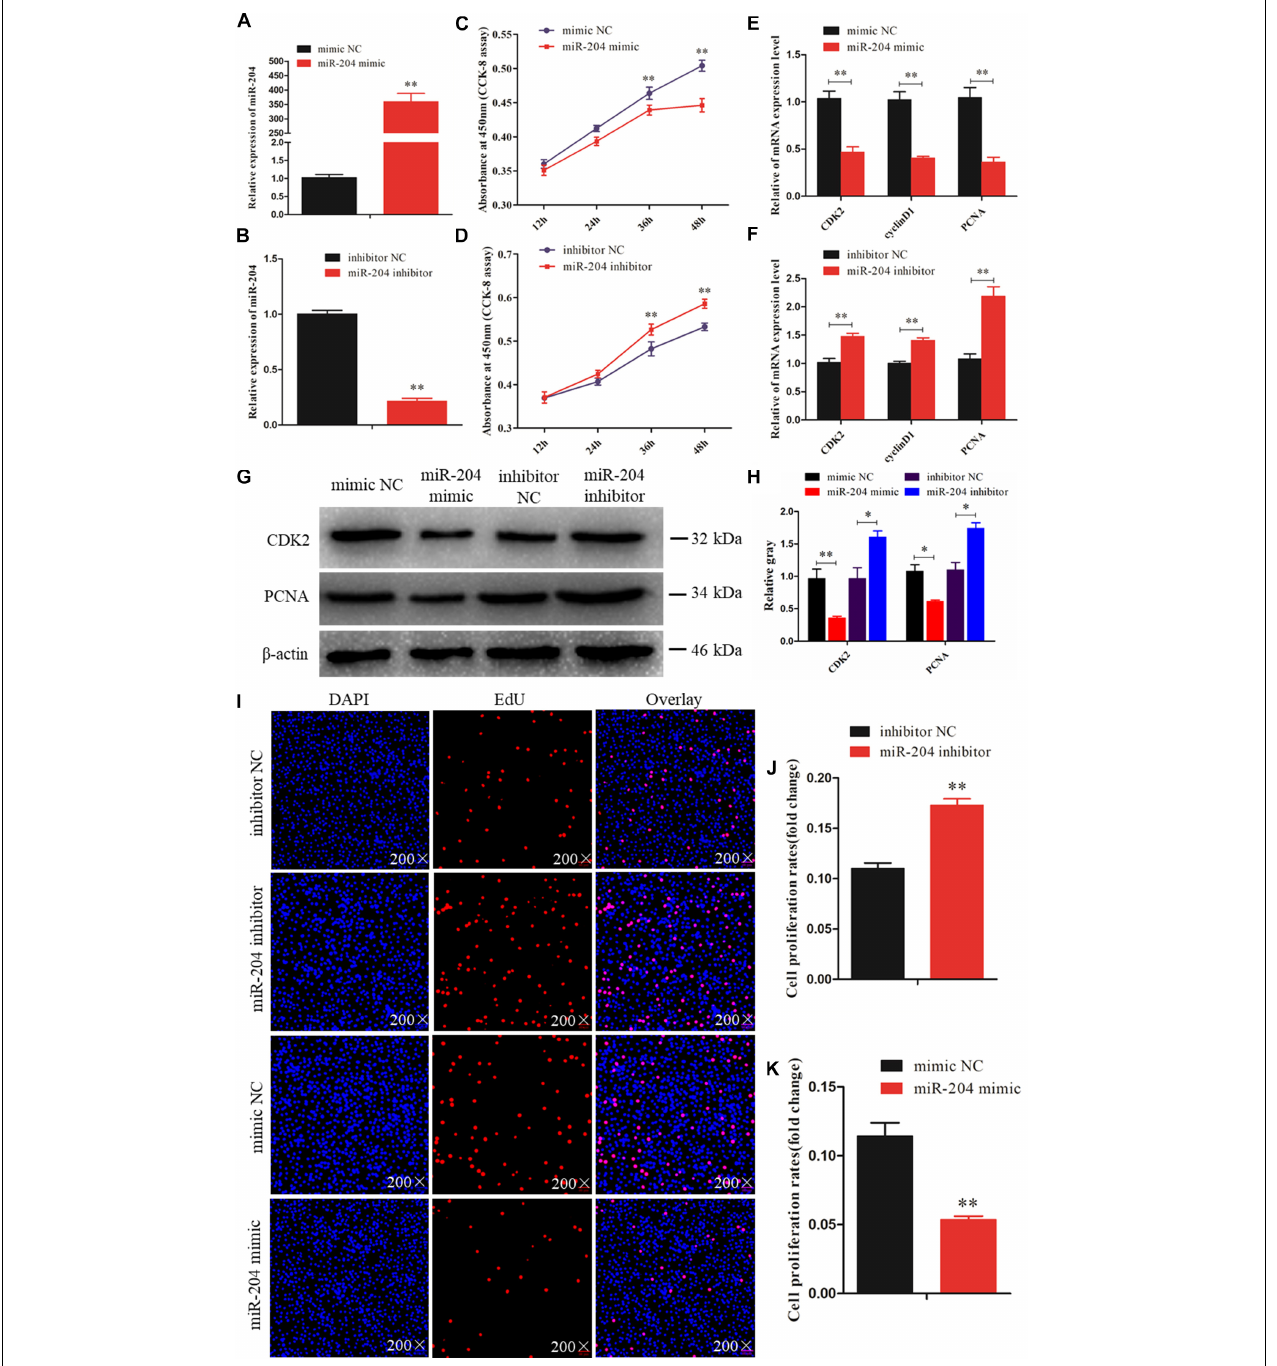
FIGURE 2 | miR-204 regulates the proliferation of chicken granulosa cells (GCs). (A) Quantitative real-time PCR (qRT-PCR) was used to determine the miR-204 expression level after transfection of miR-204 overexpression plasmid. (B) The miR-204 expression level after transfection of miR-204 inhibition plasmid. (C) Cell proliferation curves of chicken GCs were measured with cell counting kit-8 (CCK-8) reagent after overexpression of miR-204. (D) Cell proliferation curves of chicken GCs were measured with CCK-8 reagent after inhibition of miR-204. (E) Expression abundances of cell proliferation-related genes ( PCNA , CDK2 , and cyclinD1 ) were detected by qRT-PCR after overexpression of miR-204. (F) Expression levels of cell proliferation-related genes inhibited by miR-204. (G, H) The protein expression levels of cell proliferation-related genes [cyclin-dependent kinase 2 (CDK2) and proliferating cell nuclear antigen (PCNA)] were detected by Western blot analysis after a gain or loss of miR-204. β -actin was used as a reference gene. (I) 5-Ethynyl-2-deoxyuridine (EdU) staining-positive GCs were detected by EdU kit after overexpression and inhibition of miR-204. (J, K) The fold change of GC proliferation rates after overexpression and inhibition of miR-204, respectively. EdU (red), 4 (cid:48) ,6-diamidino-2-phenylindole (DAPI) (blue); Replications = 3. Data are presented as mean ± SE; * P < 0.05 and ** P < 0.01. miR, microRNA; NC, negative control.